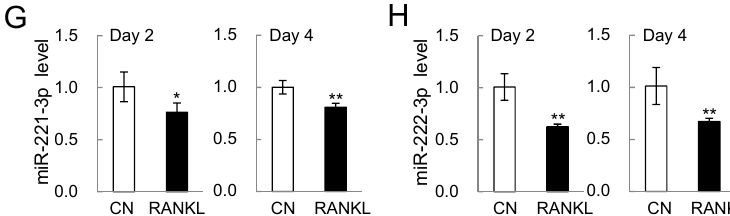
Figure 2. PCR-based mRNA and miRNA expression levels on Days 2 and 4 after RANKL addition ( n = 5). CN = control sample; and RANKL = RANKL-treated sample (20 ng/mL): The single and double asterisks indicate p < 0.05 and p < 0.01, respectively. ( A ) nuclear factor of activated T-cells, cytoplasmic 1 (NFATc1) mRNA level; ( B ) tartrate-resistant acid phosphatase (TRAP) mRNA level; ( C ) miR-125b-5b level; ( D ) miR-146a-5p level; ( E ) miR-182-5p level; ( F ) miR-27b-3p level; ( G ) miR-221-3p level; and ( H ) miR-222-3p level.